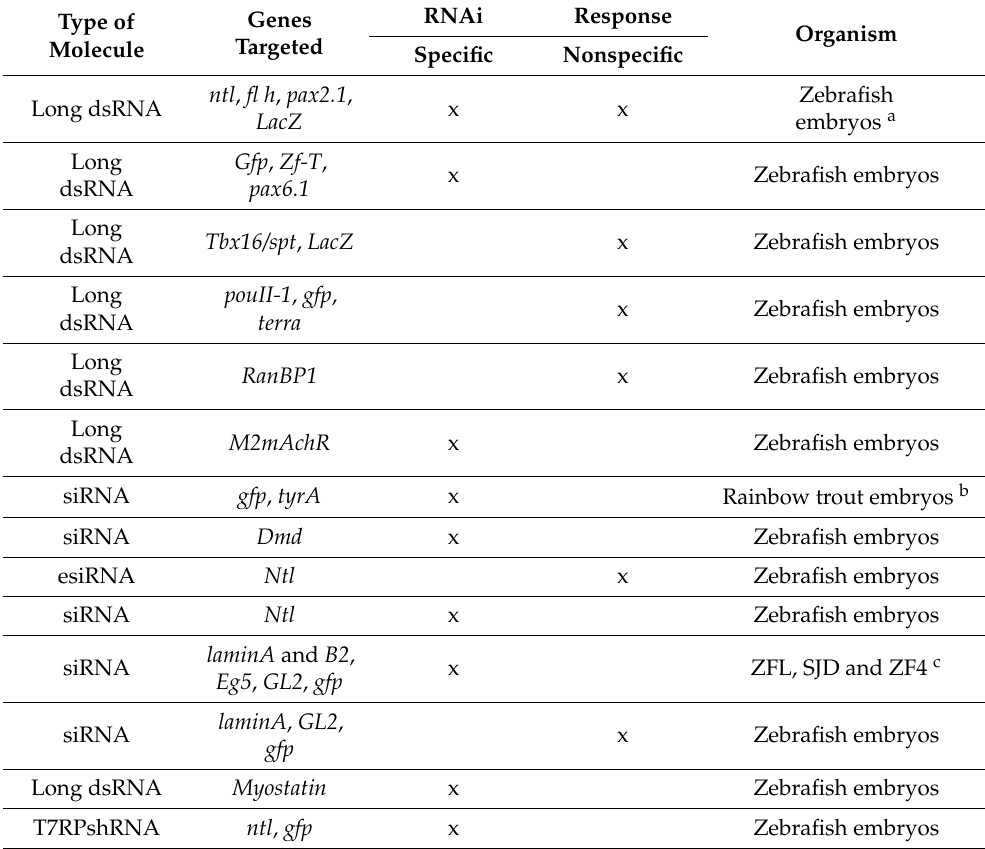
Table 2. Effective applications of the RNAi technique in fish